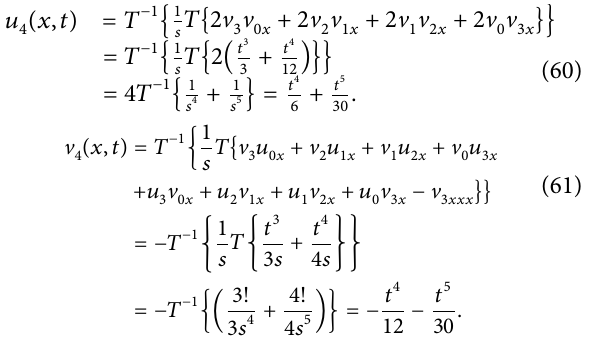
Figure 2: The figure explain the surface errors (4.2).